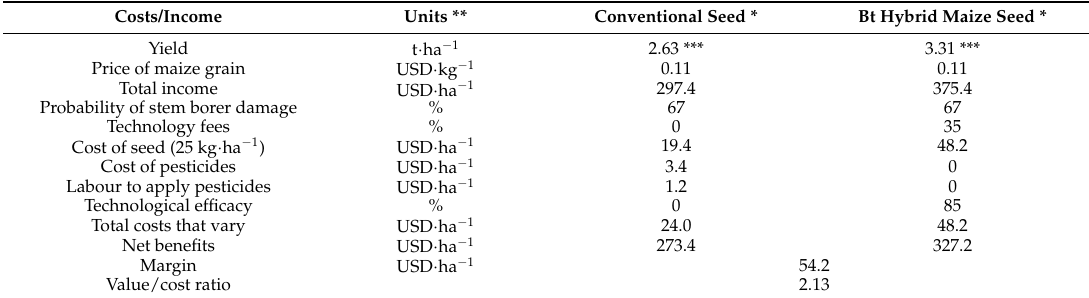
Table 4. Partial budget analysis for the use of genetically modified Bt maize for all